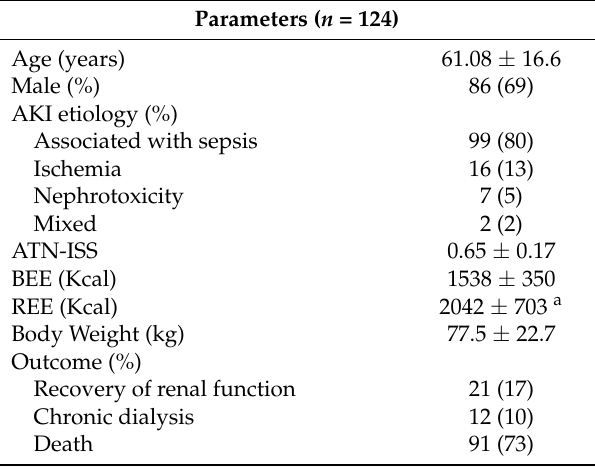
Table 1. Clinical characteristics of the general study population.